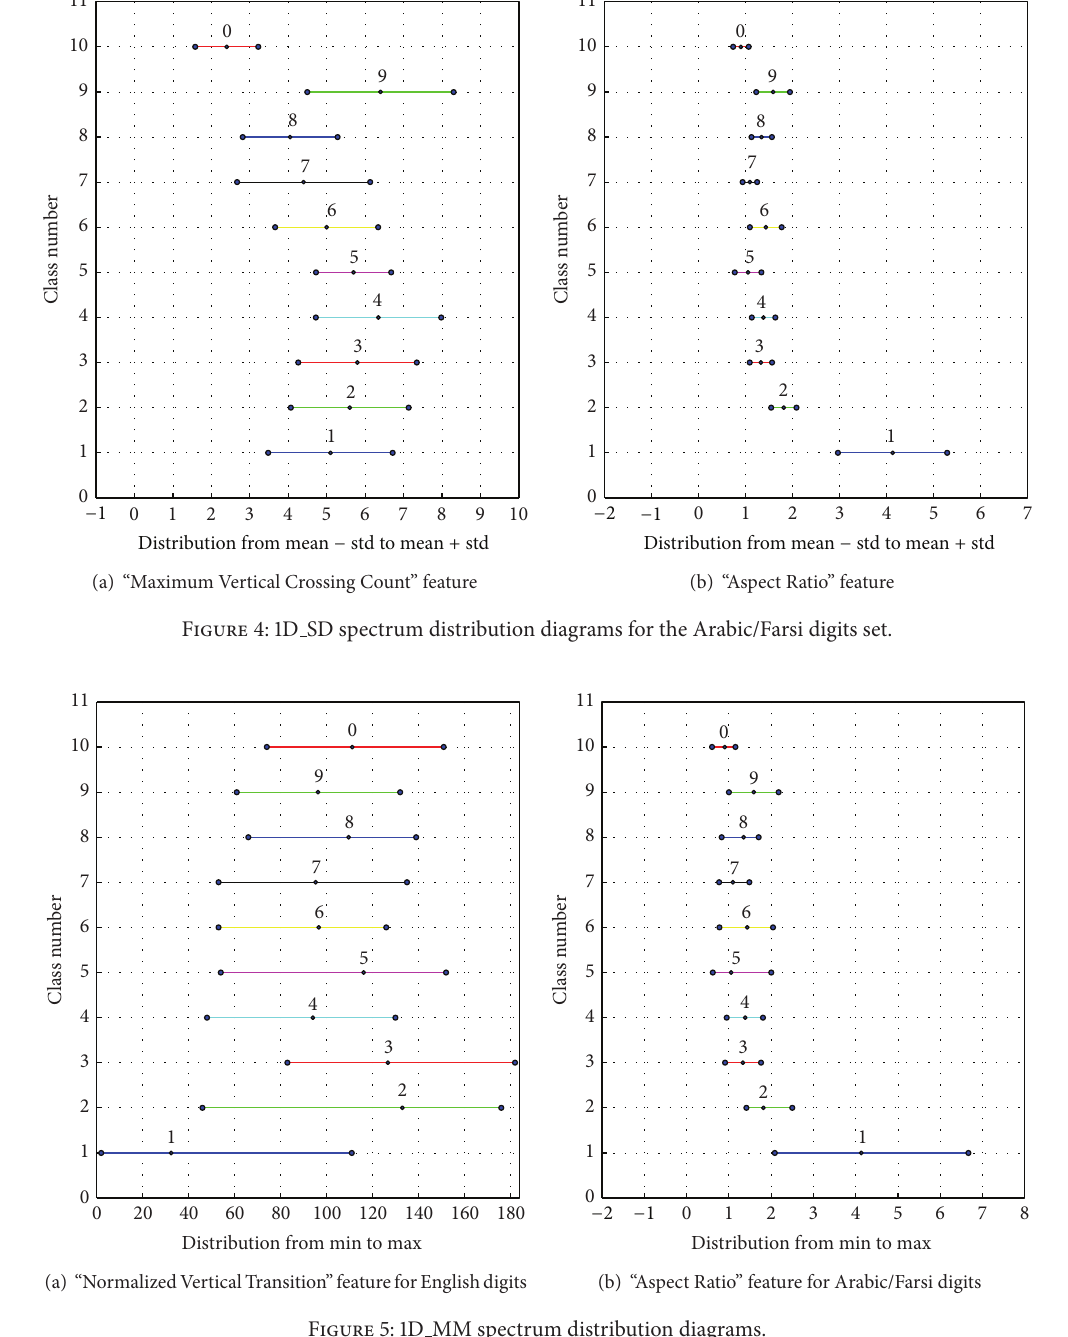
Figure 5: 1D MM spectrum distribution